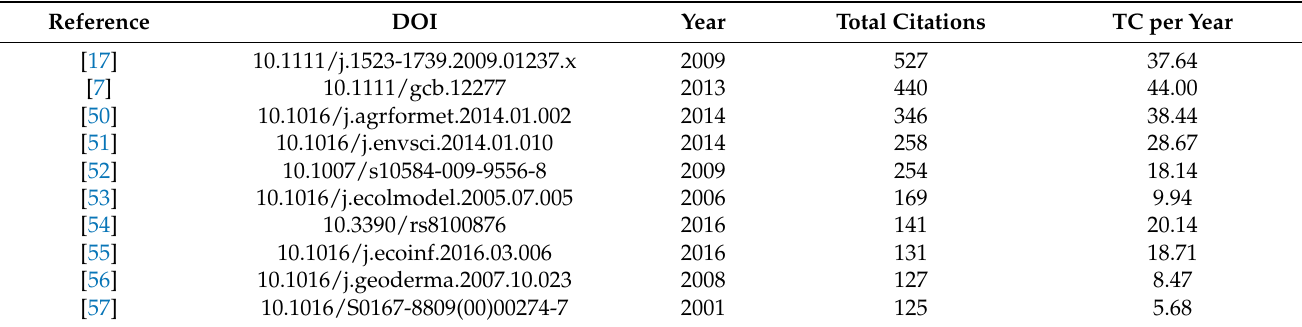
Table 3. Top ten global citation scores (GCS) of publications considering the ecological and environ- mental effects of land use and cover changes (LUCC) on the Qinghai-Tibetan Plateau